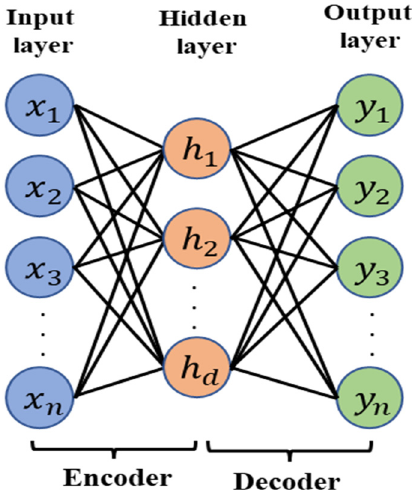
Figure 6. Basic architecture of the autoencoder.